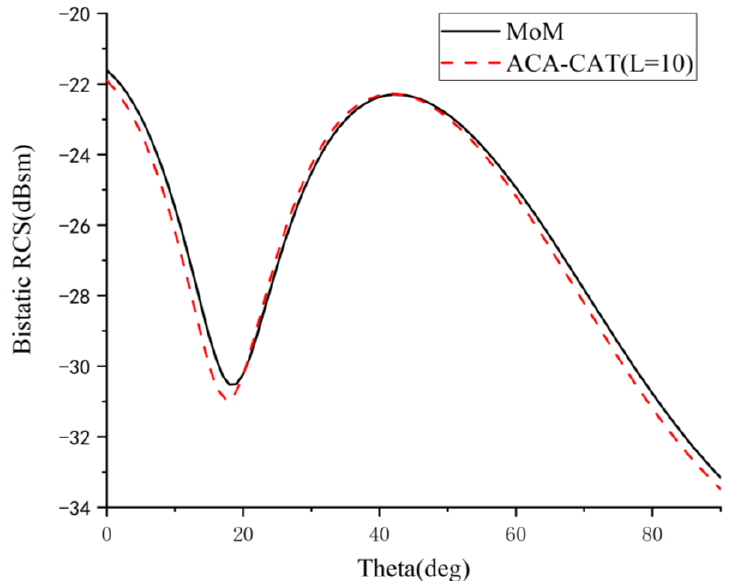
Figure 11. Bistatic RCS for the discrete objects model using MoM and ACA-CAT of the non-Gaussian sampling points.